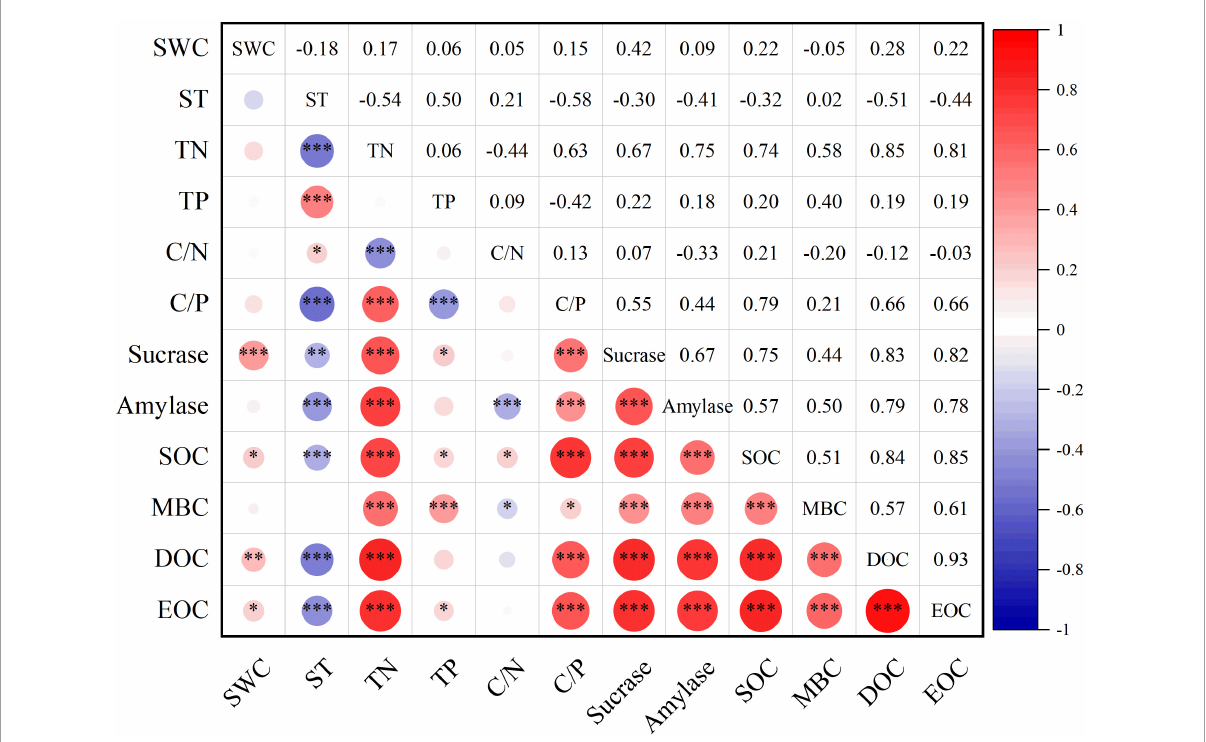
FIGURE5 Heat map of correlation between soil carbon pools and environmental factors. *, **, and *** are significantly correlated at P < 0.05, P < 0.01, and P < 0.001 levels (bilateral), respectively. SWC, Soil water content; ST, Soil temperature; TN, Total nitrogen; TP, Total phosphorus; C/N, Carbon to nitrogen ratio; C/P, Carbon to phosphorus ratio; SOC, Soil organic carbon; MBC, Microbial biomass carbon; DOC, Dissolved organic carbon; EOC, Easily oxidized organic